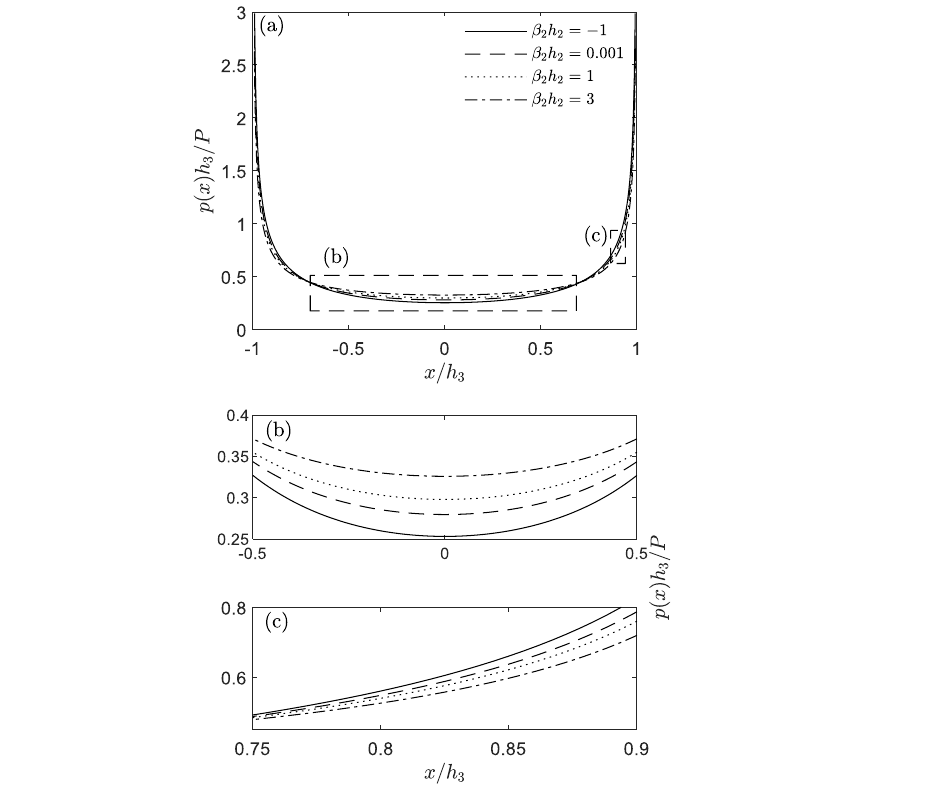
Figure 7. The effects of the inhomogeneity parameter 2 2 h  on the distribution of the non – dimen- sionalized receding contact pressure ( ) 03